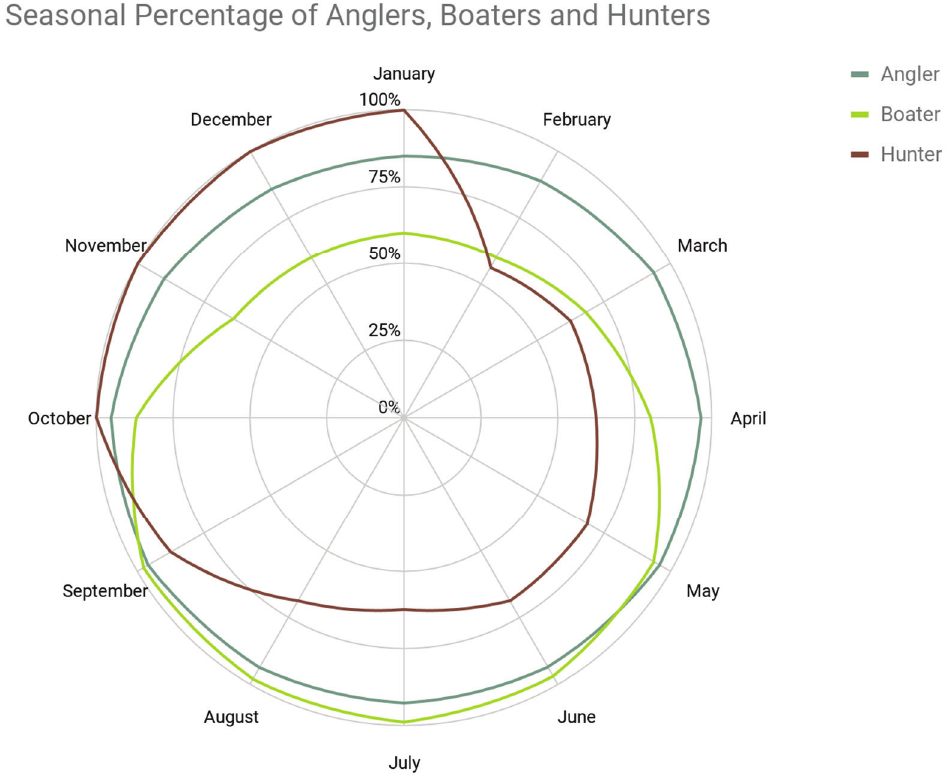
Figure 6. Calendar chart derived from categorized responses to the question: In what months are you out in Franks Tract or Little Franks Tract? Note October through November corresponds to the duck hunting